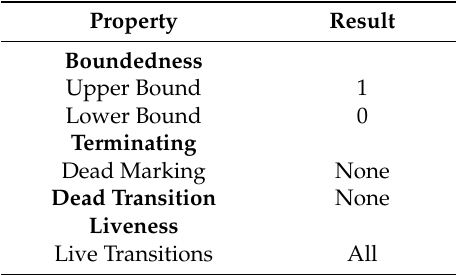
Table 2. Reachability Analysis Report for the Traffic Light